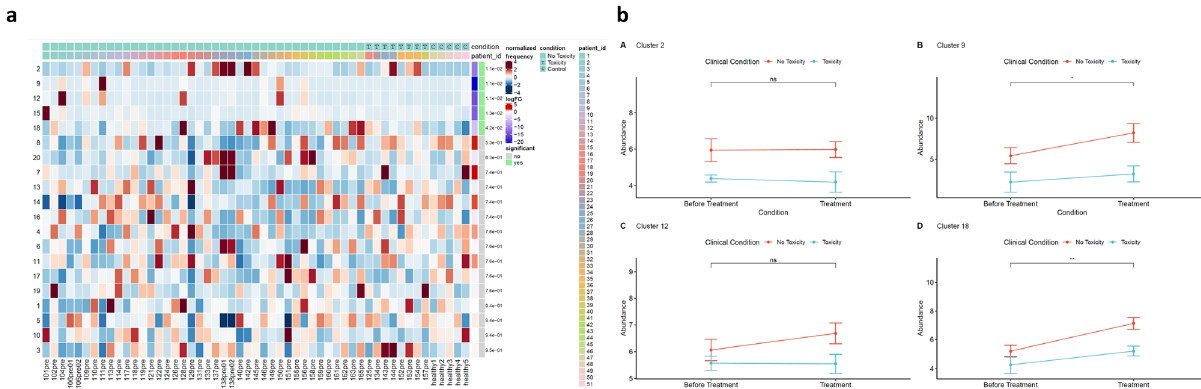
Fig. 4 Differentially abundant B-cell populations between toxicity and non-toxicity patients. a Differential abundance heatmap illustrating 20 previously identi fi ed clusters (2A) (left-hand column) with a relative normalised abundance of each cluster by individual patient and healthy control sample (main panel). Patient to patient variability was treated as a random effect in order to improve the robustness of the model. A generalised linear mixed regression model was applied to determine the signi fi cance of differential abundance between conditions (toxicity and non-toxicity); the top fi ve clusters were of statistical signi fi cance as shown by the green bars. Of these, four are the identi fi ed Breg populations. PDL1 hi CD38 int CD95 int TGF β -ve IL-10 -ve Breg ( P = 0.011) (cluster 2 from initial unsupervised analysis), PD-1 hi CD5 hi CD25 hi CD27 hi CD24 lo CD38 lo IL-10 int Breg ( P = 0.011) (cluster 9 from initial unsupervised analysis), CD5 hi CD24 lo CD25 lo CD27 lo IL-10 lo Breg ( P = 0.011) (cluster 12 from initial unsupervised analysis) and PDL1 hi CD38 int CD95 lo TGF β hi IL-10 lo Breg ( P = 0.042) (cluster 18 from initial unsupervised analysis). Cluster 15, an identi fi ed Transitional B-cell population (IgM hi CD5- CD21 hi CD10 hi CD24 hi CD38 hi ) was also signi fi cantly more abundant in non-toxicity patients ( P = 0.013). b Longitudinal analyses demonstrate signi fi cant increases in circulating Breg number post-treatment with checkpoint blockade therapy. Line plots indicate the fold change in circulating Breg cluster abundance before and after treatment with sub-strati fi cation according to those who developed high-grade irAE after treatment ( n = 19 biologically independent samples). Changes are shown for four major Breg phenotypes identi fi ed in the initial unsupervised analysis. None of the patients who developed toxicity post-treatment patients experienced signi fi cant increases in the circulating population number. The P value indicators are for non- toxicity patients. PDL1 hi CD38 int CD95 int TGF- β -ve IL-10 lo (2) [ P = 0.952]; PD-1 hi CD5 hi CD25 hi CD27 hi CD24 lo CD38 lo IL-10 int (9) [ P = 0.035]; CD5 hi CD24 lo CD25 lo CD27 lo IL-10 lo (12) [ P = 0.104]; PDL1 hi CD38 int CD95 lo TGF β hi IL-10 lo (18) [ P = 0.009]. Data are presented as mean values + / − SEM. Statistical signi fi cance was determined by two-tailed pairwise Wilcoxon signed-rank test (signi fi cance level P < 0.05). *P < 0.05 , **P < 0.01 , ***P < 0.001. Source data are provided as a Source Data fi